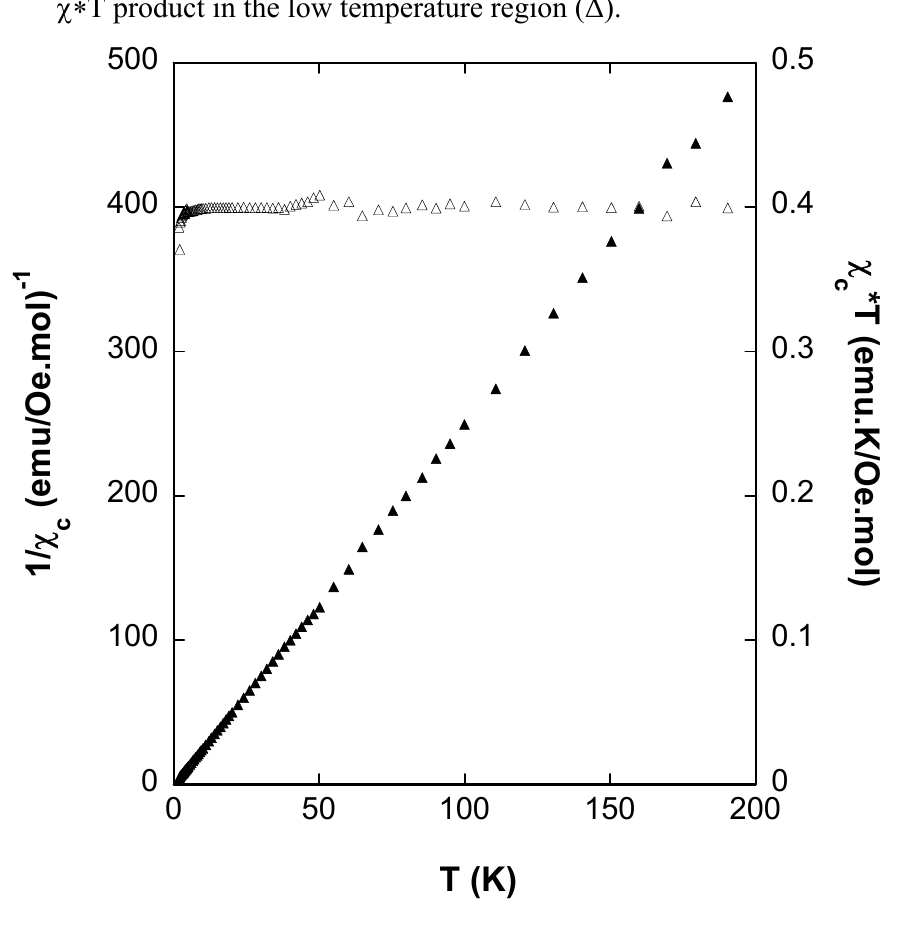
Figure 5: Temperature dependence of 1/ χ for 4 ( ▲ ) and temperature dependence of the χ∗ T product in the low temperature region ( ∆